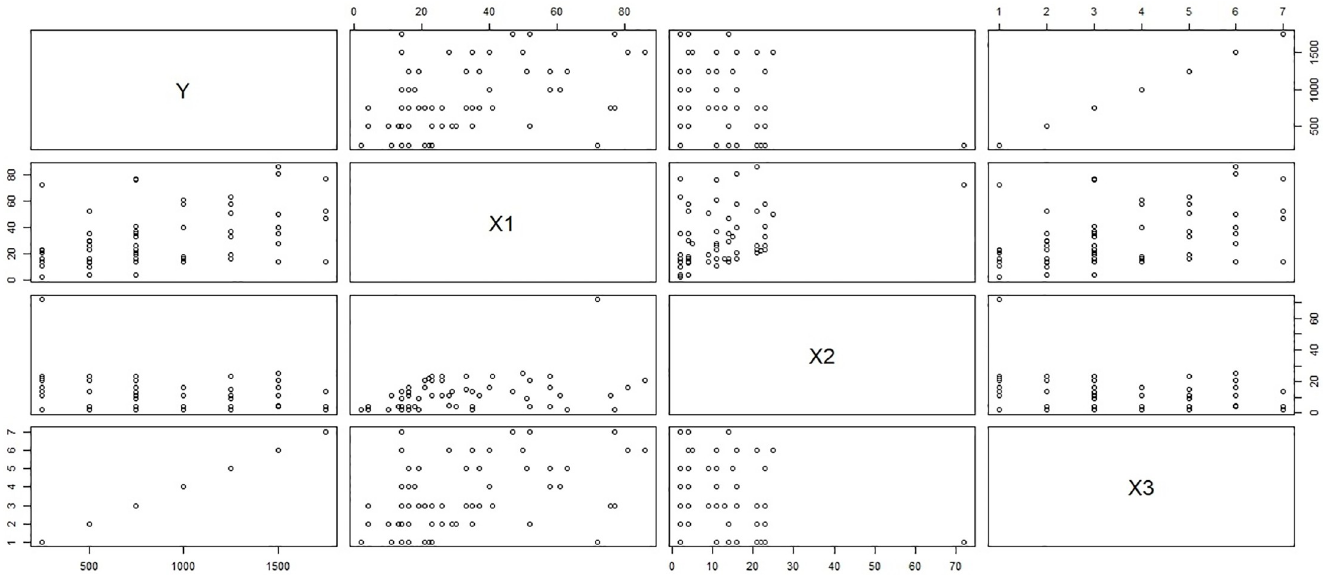
Fig 4. Behavior of respondents with λ 2 =